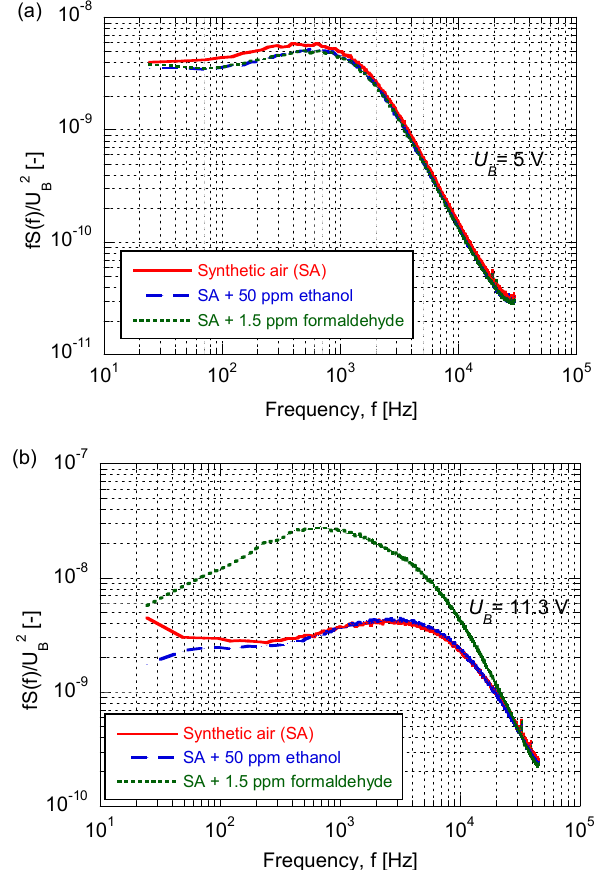
Figure 3. Power spectral density S ( f ) of an AuNP-based sensor’s voltage fluctuations, multiplied by frequency f and normalized by the square of the sensor’s bias voltage U B , upon exposure to the shown gases